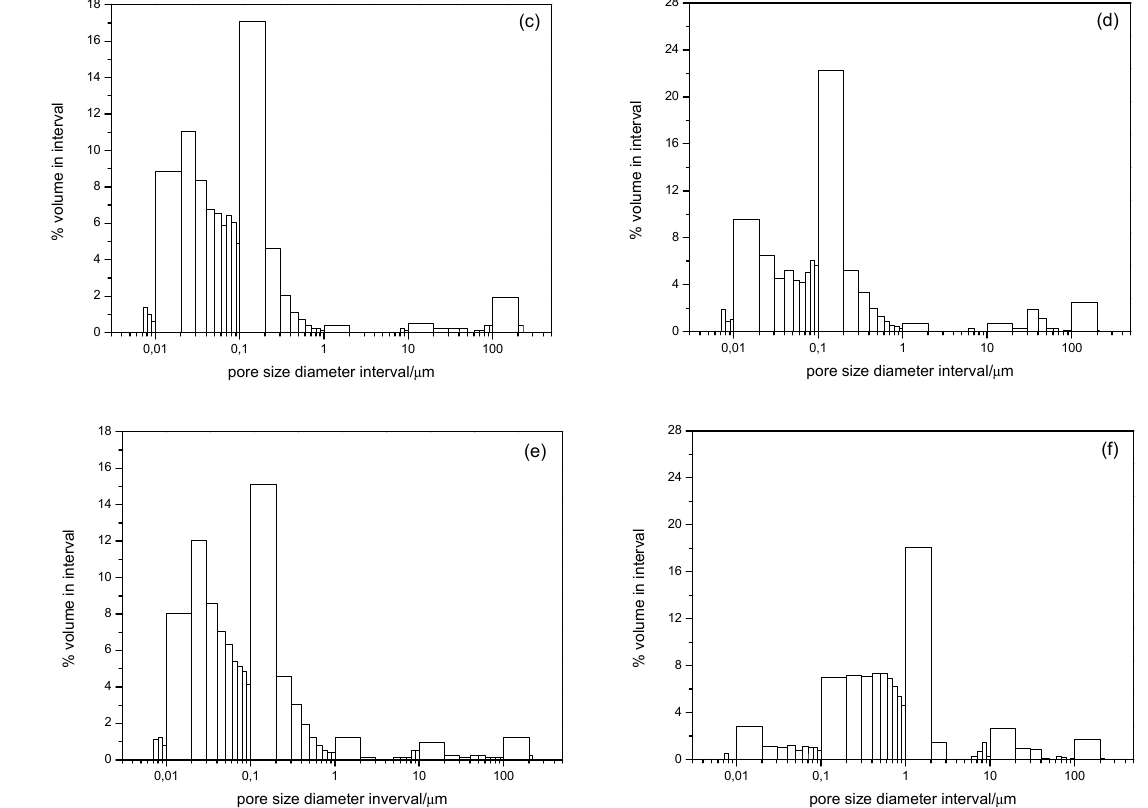
Figure 3. Porosity distribution of the samples: G ( a ), W ( b ), G-5 ( c ), W-5 ( d ), G-10 ( e ) and W-10 ( f ).